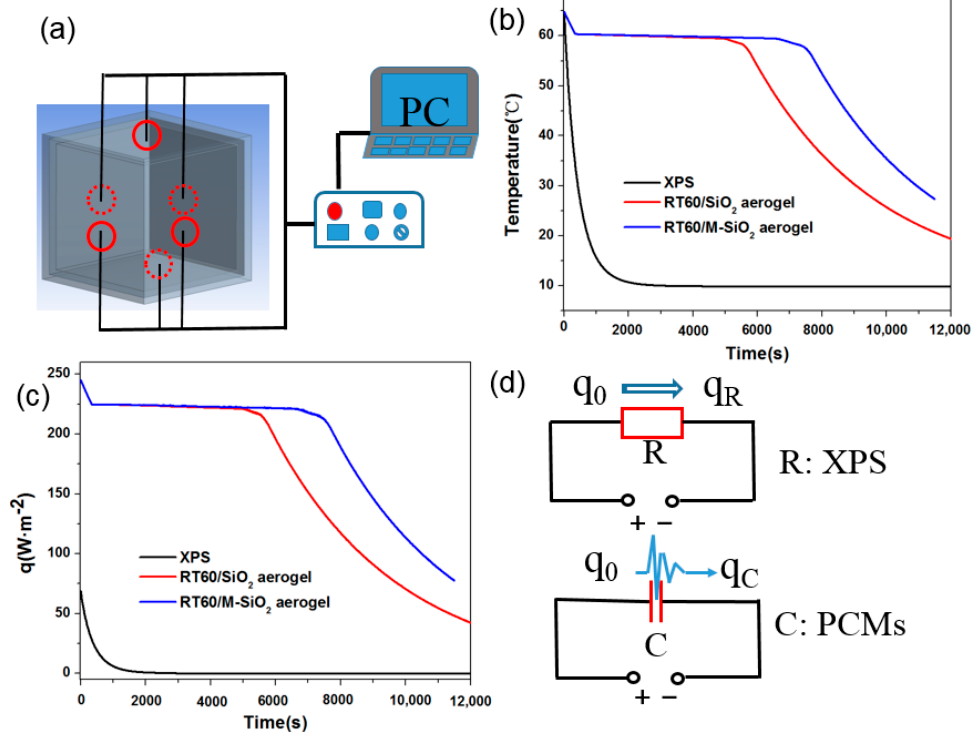
Figure 10. Experimental setup of thermal barrier property of M-SiO 2 aerogel-based PCM ( a ), temperature response curve of SiO 2 and M-SiO 2 aerogels based PCMs ( b ), the rectified heat flow of the XPS form, SiO 2 aerogel, and M-SiO 2 aerogel-based PCMs ( c ), and the equivalent circuits of two kinds of thermal barrier boxes ( d ).